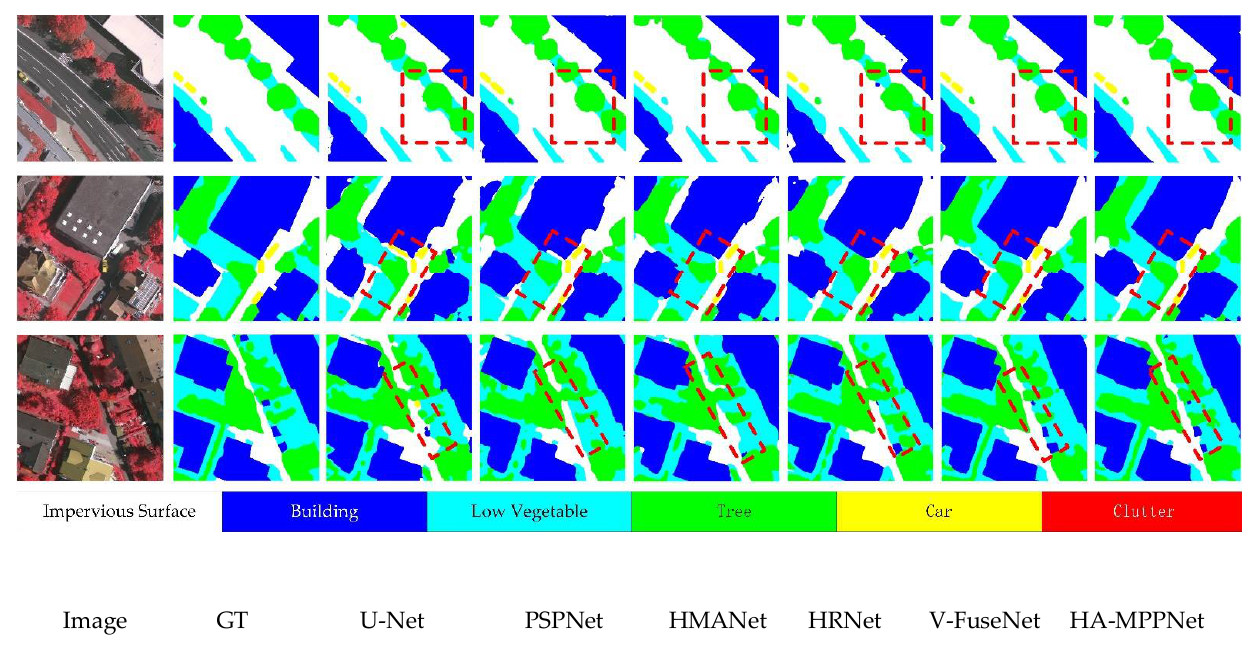
Figure 7. Selected samples of the segmentation maps on the Vaihingen dataset.